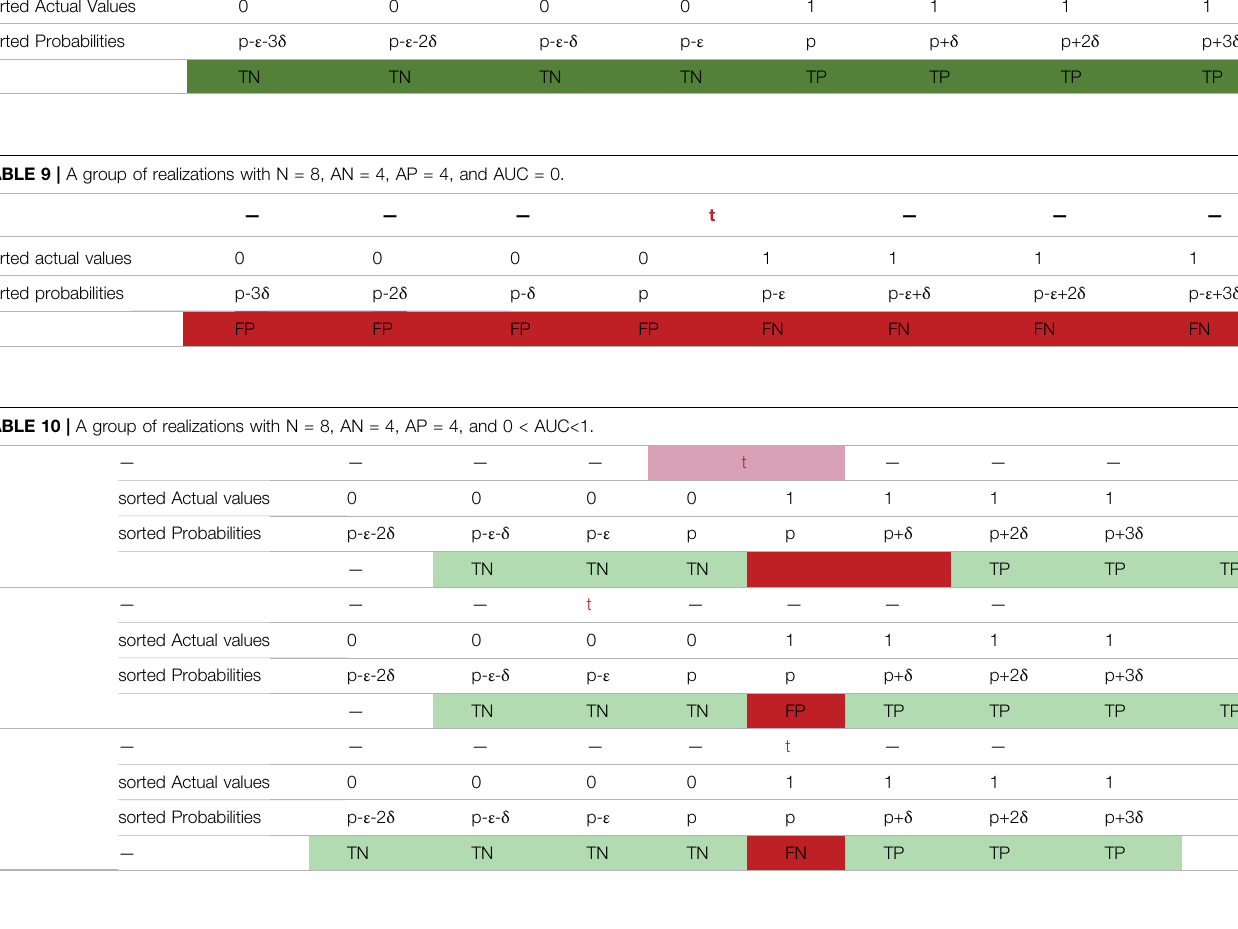
( Table 10 ), which means TPR is 1 and FPR is positive. For ( Table 10 ), which means FPR (cid:1) 0 and TPR less than one. In other words, in the ROC curve, ( Tables 10(b),(c) ) correspond to points ( d 1 ,1) and (0, d 2 ), respectively, where d 1 and d 2 are positive real numbers ( Figure 6 ). Obviously, this causes a reduction in AUC as much as the area of a triangle. (0, d 2 ), ( d 1 ,1), and (0, 1) are vertices of the triangle. FN contributes to TPR whereas FP is part of FPR. Therefore, d 1 is in fl uenced by FP and d 2 , is a function of FN. Because they both play a role in the